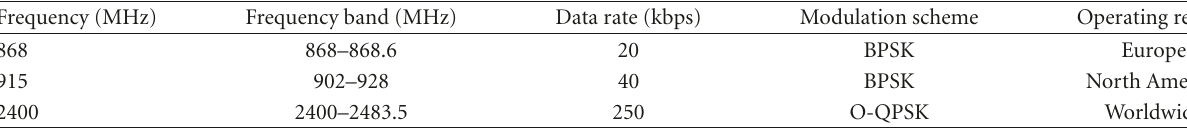
Table 1: IEEE 802.15.4 frequency bands.